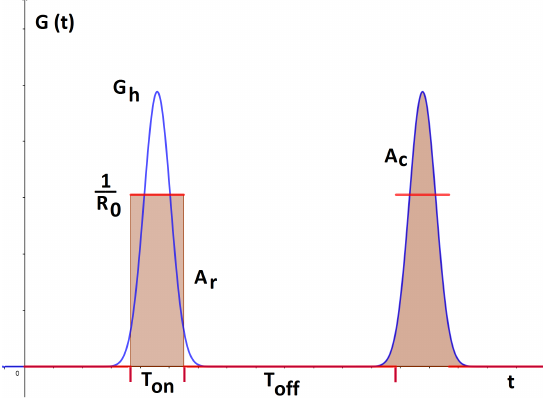
Figure 4. The duty cycle for the nonlinear load G(t).